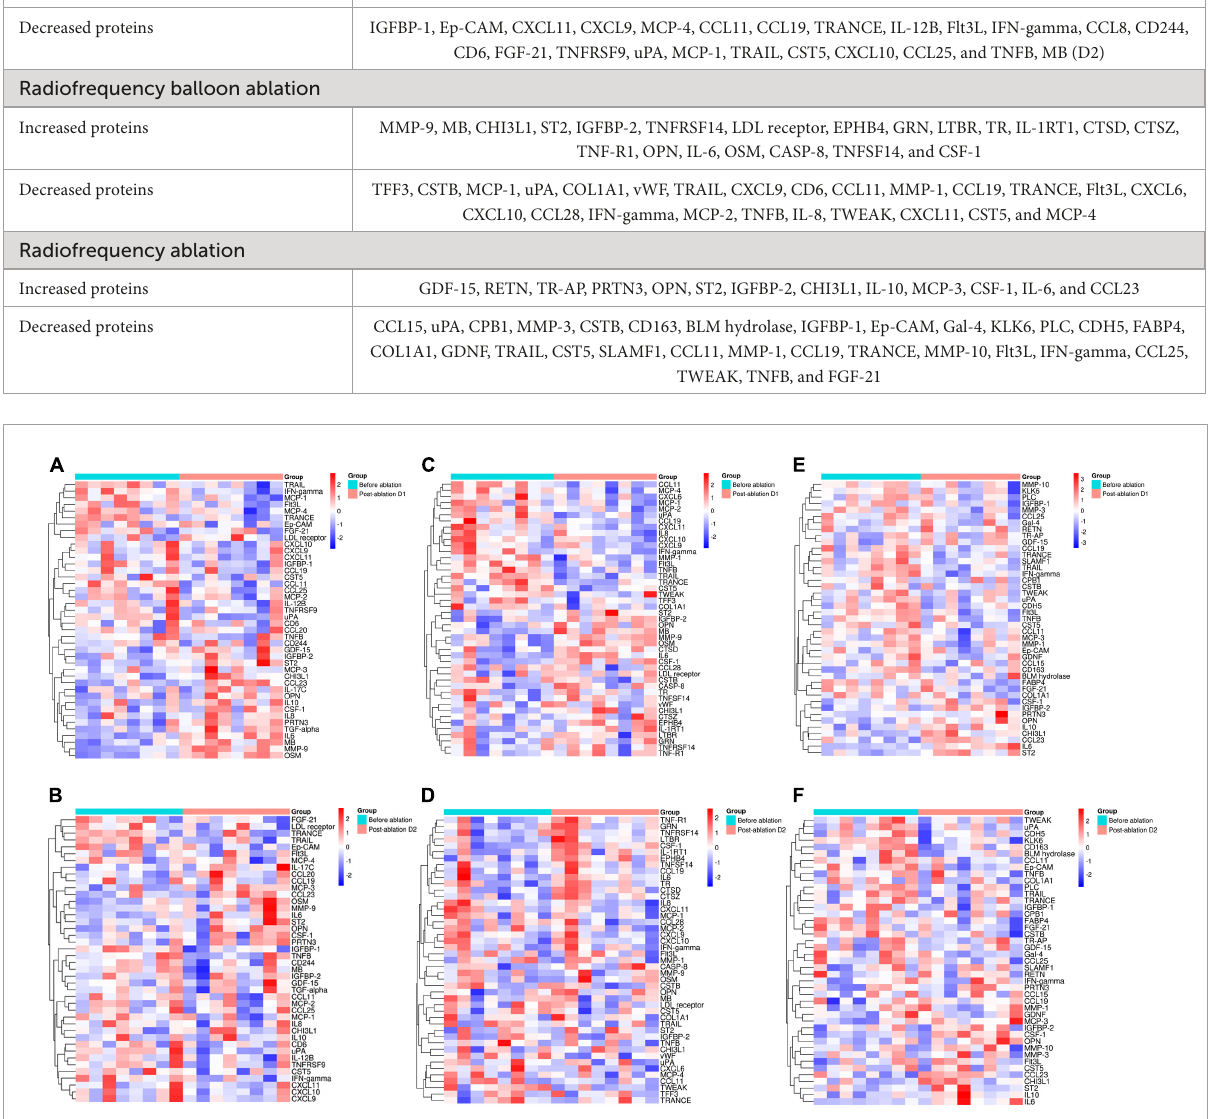
FIGURE2 Heatmap of altered proteins before and after ablation. Most of the altered proteins changed on the first day after ablation. The heatmap of the altered proteins before and after ablation D1 and D2 in the cryoballoon group (A,B) , the radiofrequency balloon group (C,D) , and the radiofrequency group (E,F) (red: high expression and blue: low expression).